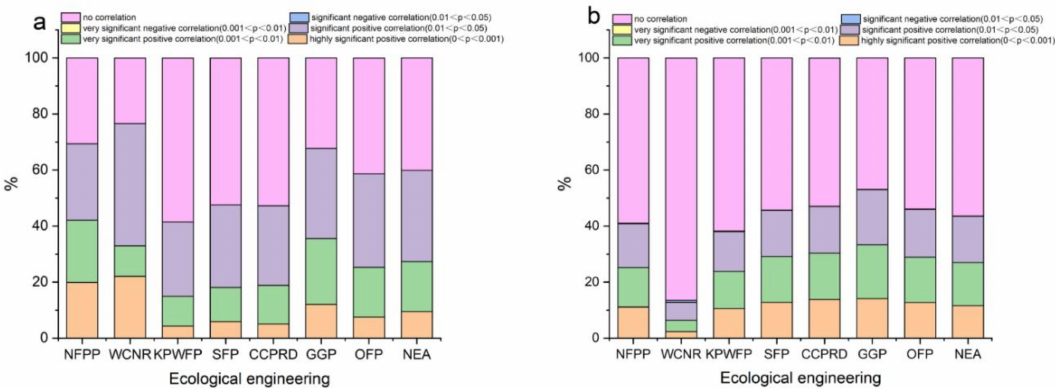
Figure 13. Proportion of positive and negative correlation between ( a ) precipitation and SCS and ( b ) VFC and SCS on the Guizhou Plateau under the e ff ect of di ff erent ecological engineering